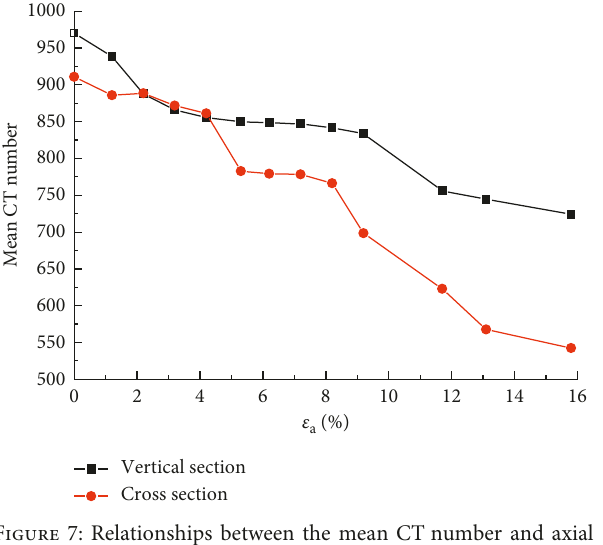
Figure 7: Relationships between the mean CT number and axial strain.